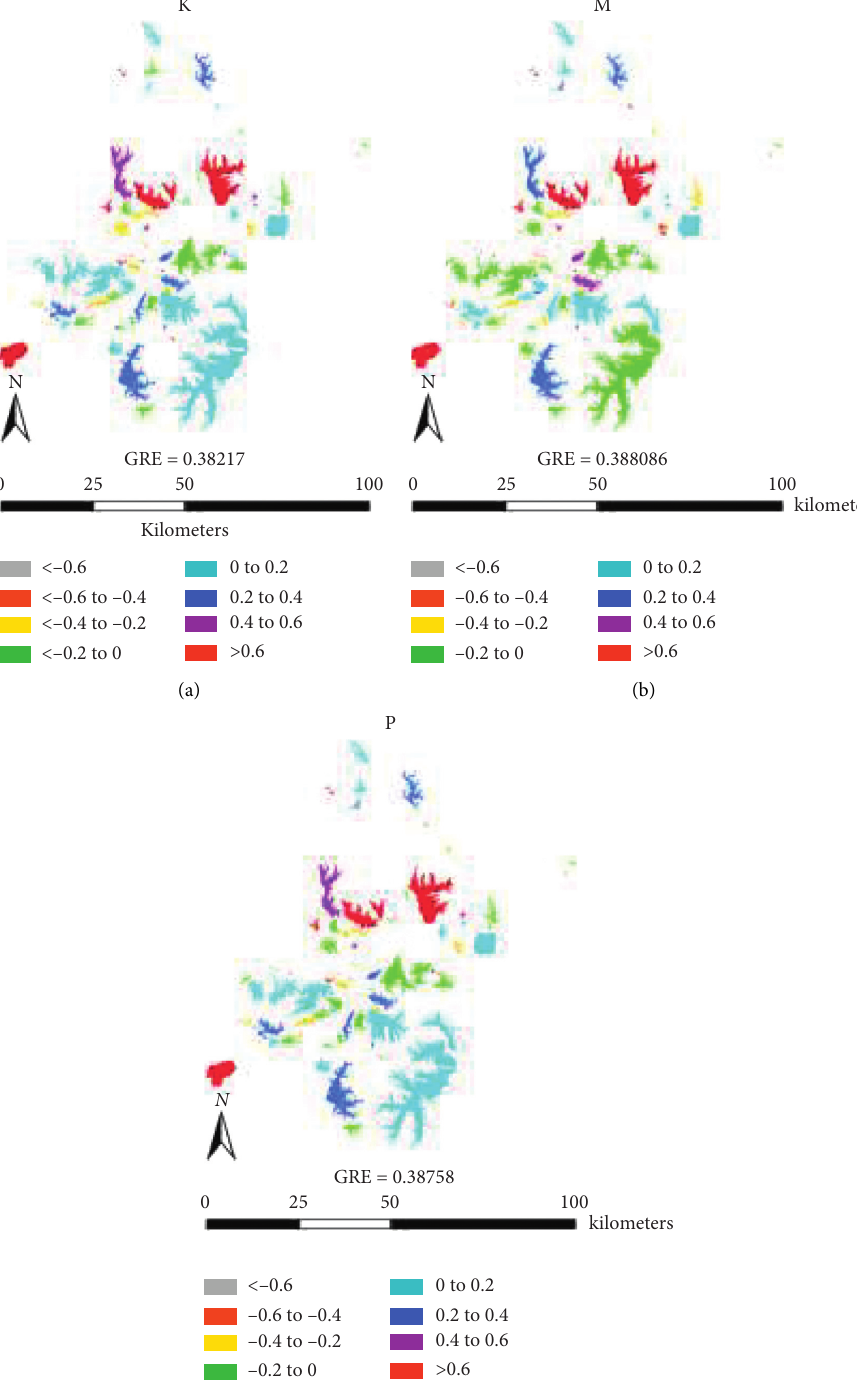
Figure 15: The spatial distribution of LRE of Groups (a) K, (b) M, and (c)